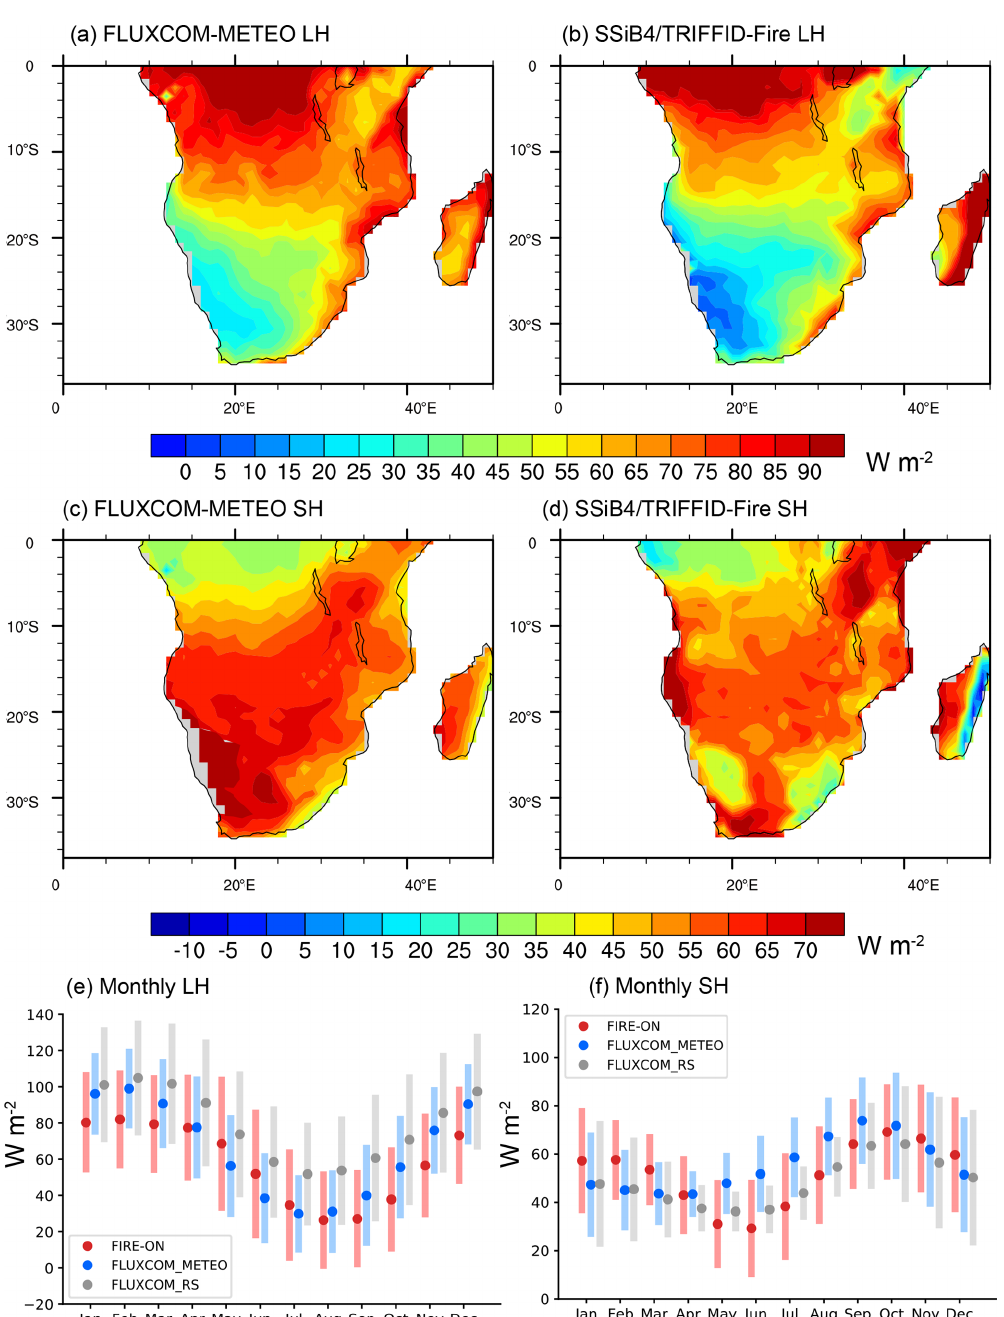
Figure 6. Annual LH (Wm − 2 ) averaged over 2000–2013 in (a) FLUXCOM-METEO and (b) SSiB4/TRIFFID-Fire; annual SH (Wm − 2 ) averaged over 2000–2013 in (c) FLUXCOM-METEO and (d) SSiB4/TRIFFID-Fire; monthly (e) LH and (f) SH for grid within SAF in the model, FLUXCOM-METEO, and FLUXCOM-RS. The dots in panels (e) and (f) denote the regional mean values, while the bars denote the LH/SH values within 1 standard deviation of the mean value of all grid